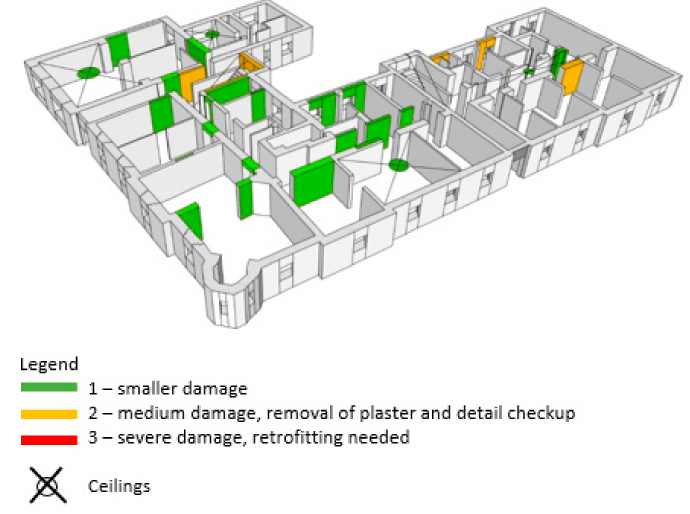
Figure 10. Damage scheme for the 1st floor of the